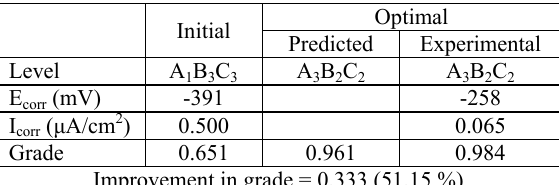
Figure 7. Tafel plots of bare and electroless Ni-P-W coated